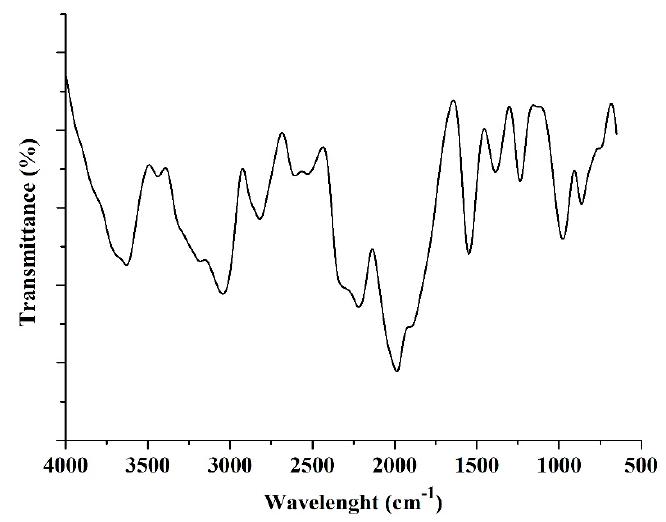
Figure 5. FTIR (Fourier-transform infrared) spectra of hybrid CNTs.